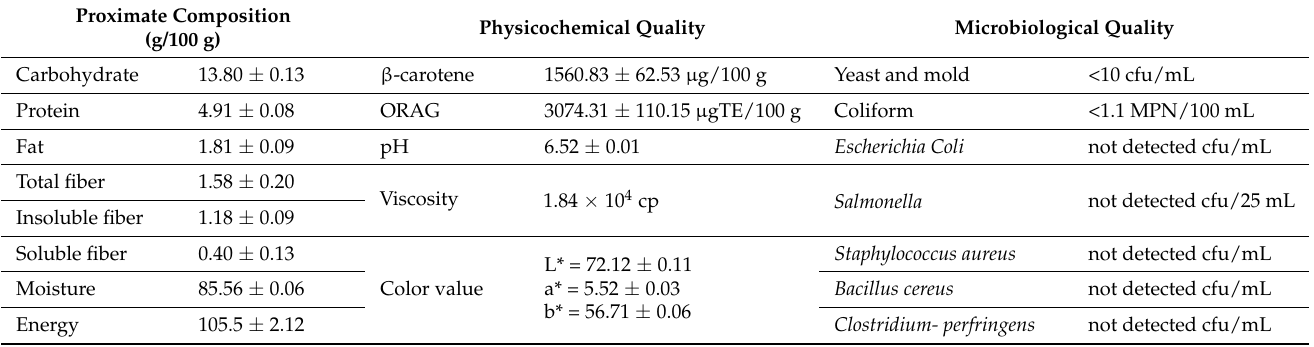
Table 3. Proximate, physicochemical, and microbiology quality of selected elderly soup products (formula